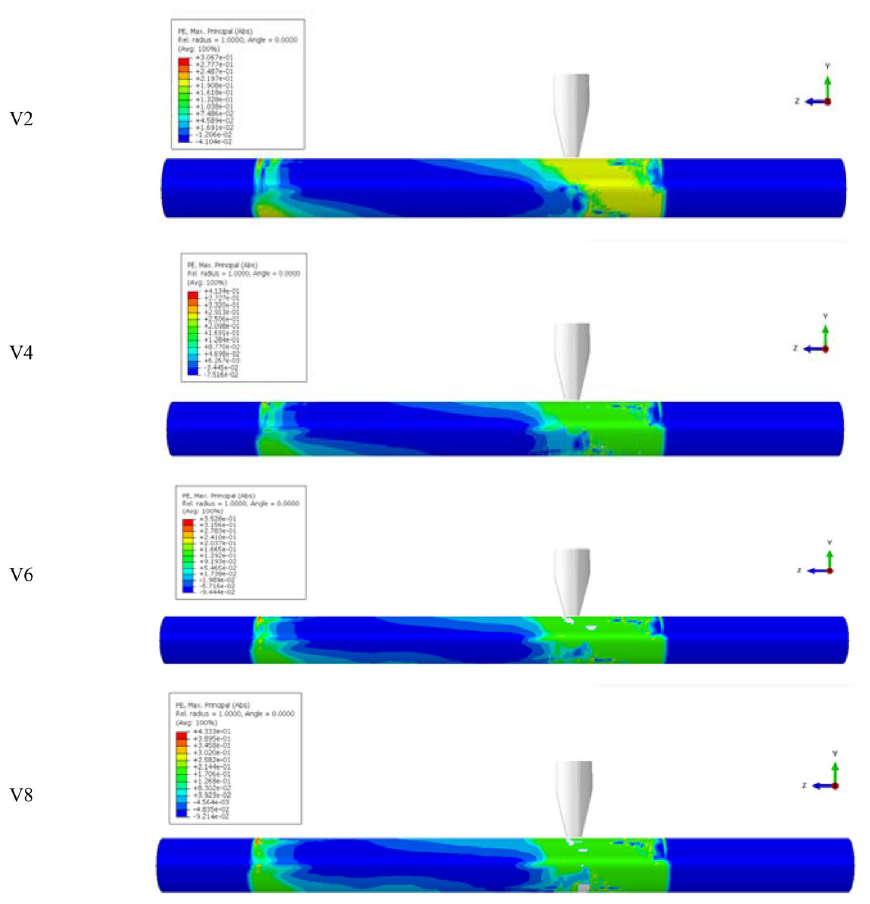
Figure 15. Plastic strain diagrams of members with different impact